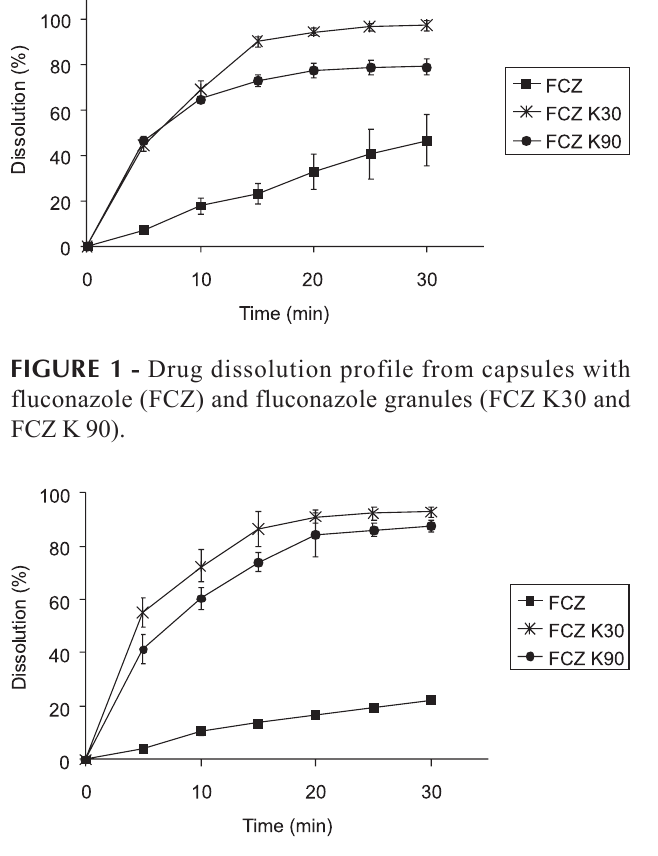
FIGURE 2 - Drug dissolution profile of tablets produced with fluconazole (FCZ) and granules (FCZ K30 and FCZ K90).